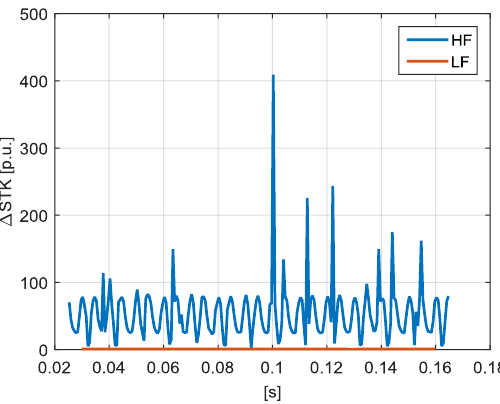
Figure 14. Case study 2: Δ STK at low-frequency (0 ÷ 2 kHz, red line) and at high-frequency (2 ÷ 150 kHz, blue line) obtained by the instantaneous approach.